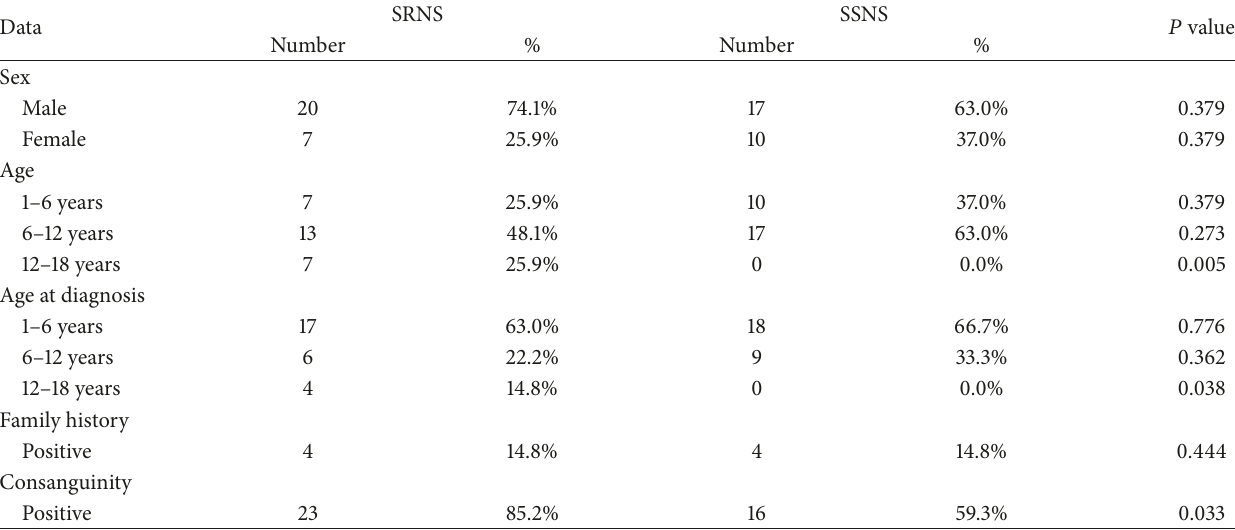
Table 1: Distribution of the study group according to demographic